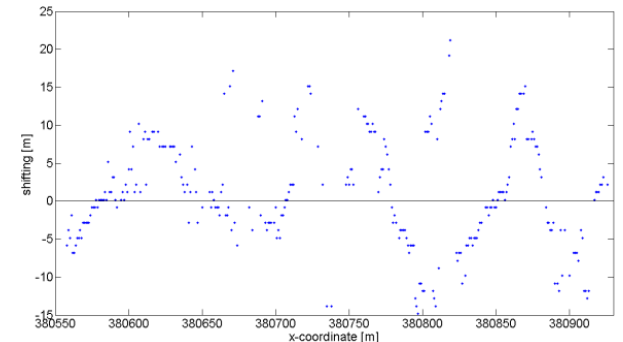
Figure 7. DTM of 2010 (top) and 2012 (bottom) with the derived skeletons for 2010 (green) and 2012 (red) for the channel in Area a .